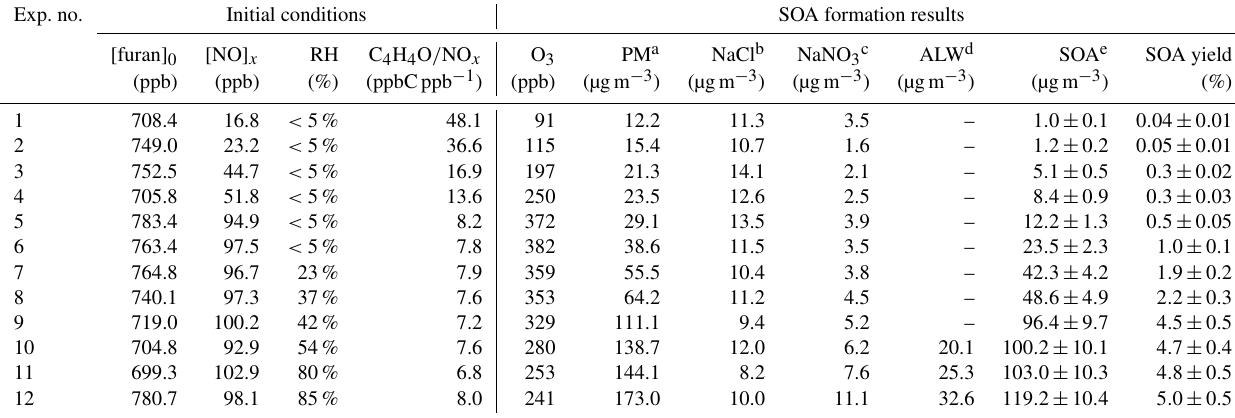
Table 1. Summary of initial conditions, O 3 concentrations, and particle mass concentrations in furan–NO x –NaCl photooxidation experiments Exp.